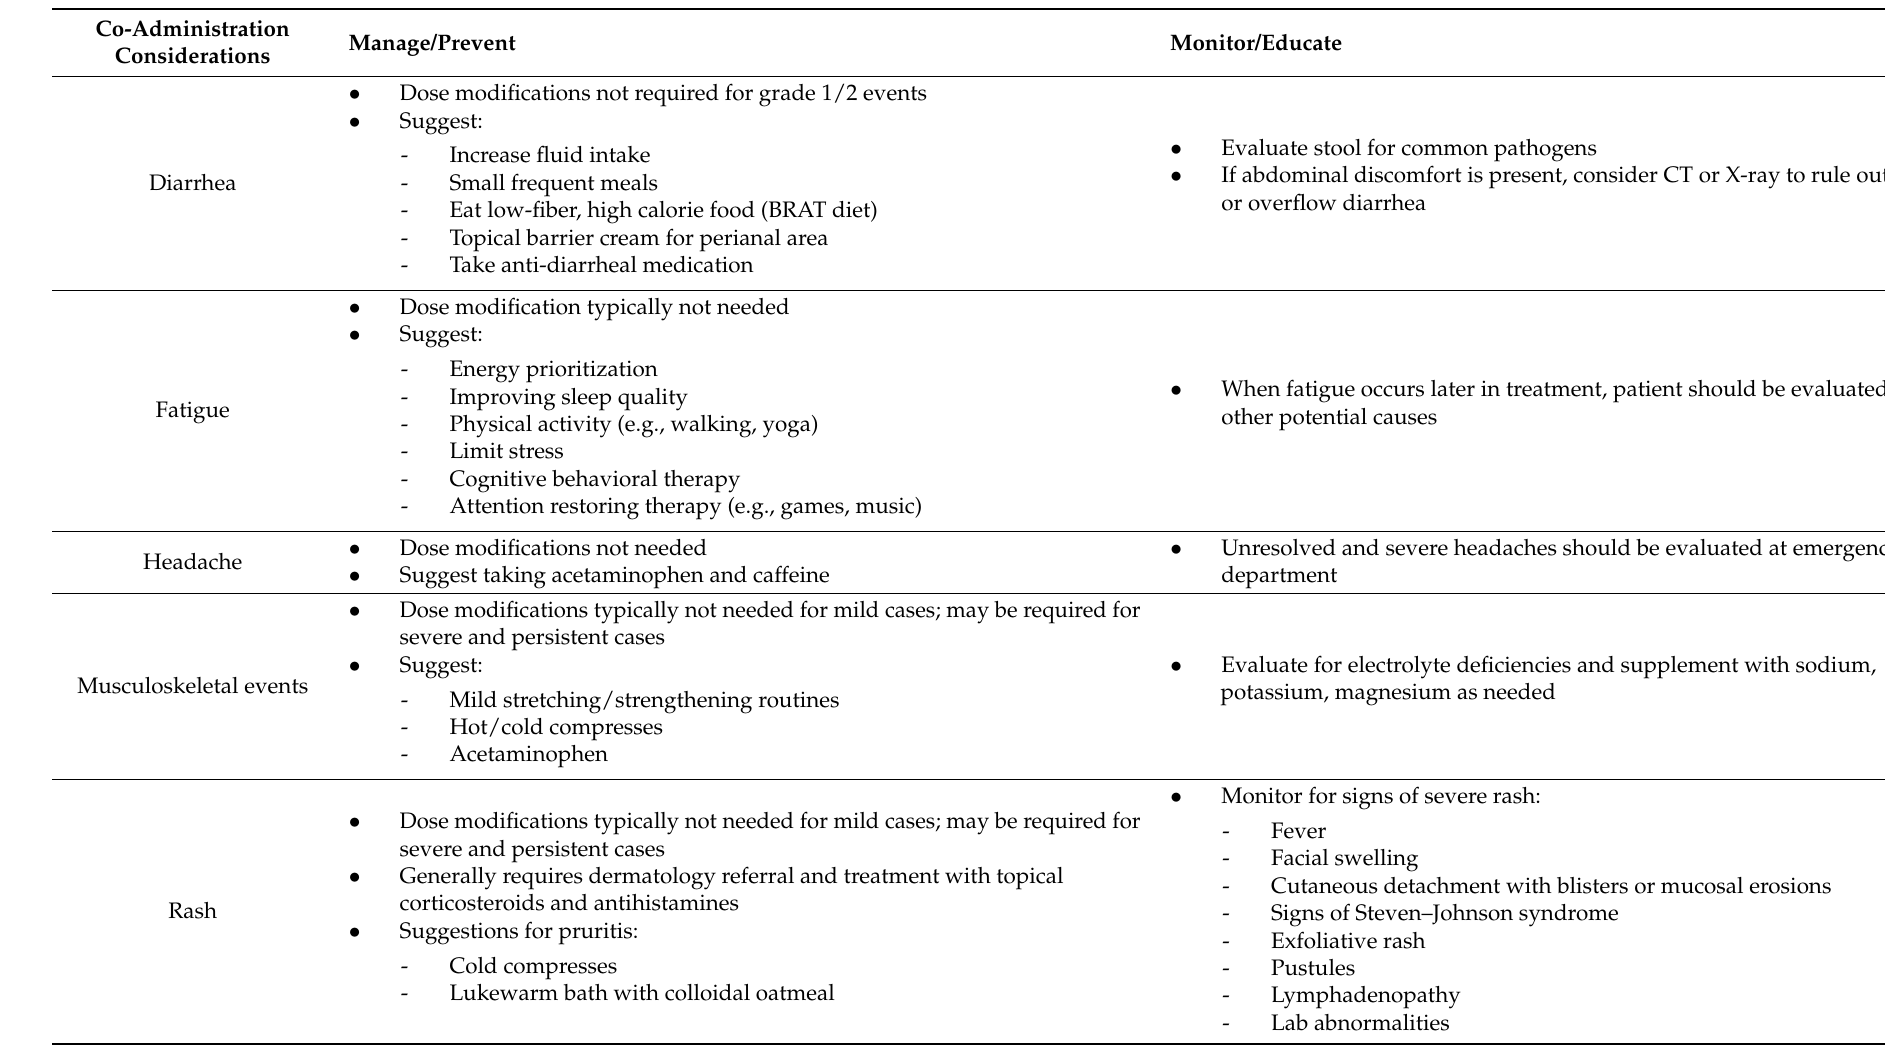
Table 6. Summary of the management and monitoring strategies for BTK inhibitor-associated adverse